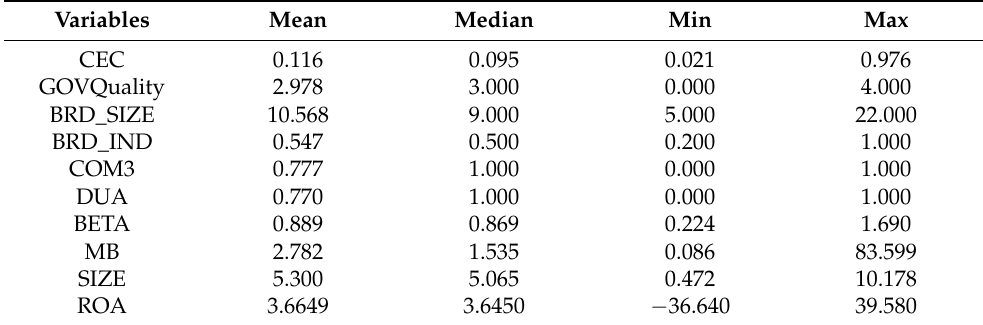
Table 3. Descriptive